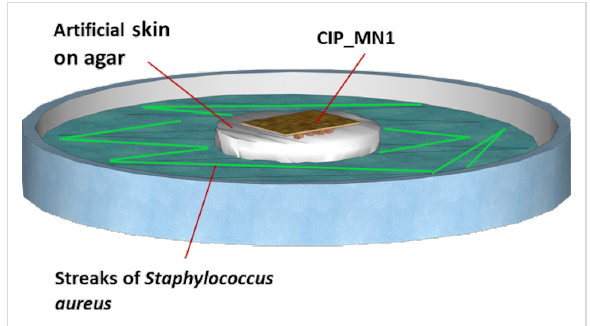
Figure 3: In vitro model for the antimicrobial activity of CIP_MN1. Preincubated inoculum of S. aureus is streaked over an agar plate. An artificial agarose-based skin is then put on the top of the agar. A microneedle array of ciprofloxacin, free ciprofloxacin gel, or blank microneedles were put on the surface of the agar. After incubation for 24 h, CIP_MN1, free CIP gel, or blank microneedles were removed, and the zone of inhibition was measured in millimeters using a